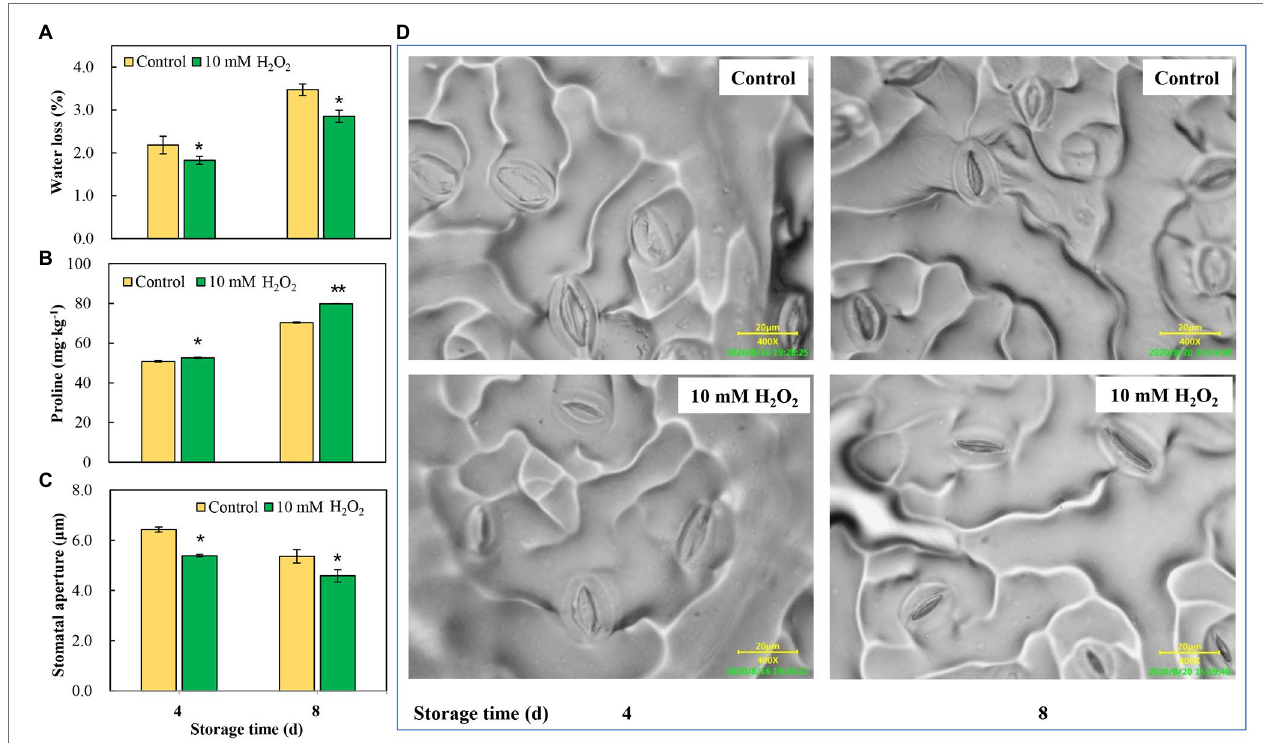
FIGURE 5 | The effects of preharvest application of 10 mM H 2 O 2 in water retention of Chinese flowering cabbage leaves during storage. The regulation of water loss (A) , proline content (B) and stomatal apertures (C,D) of Chinese flowering cabbage leaves during storage. Error bars represent one SD. Asterisks indicate that the mean values of H 2 O 2 treatment are significantly different from those of the control (* p < 0.05, ** p < 0.01), according to Duncan’s multiple range